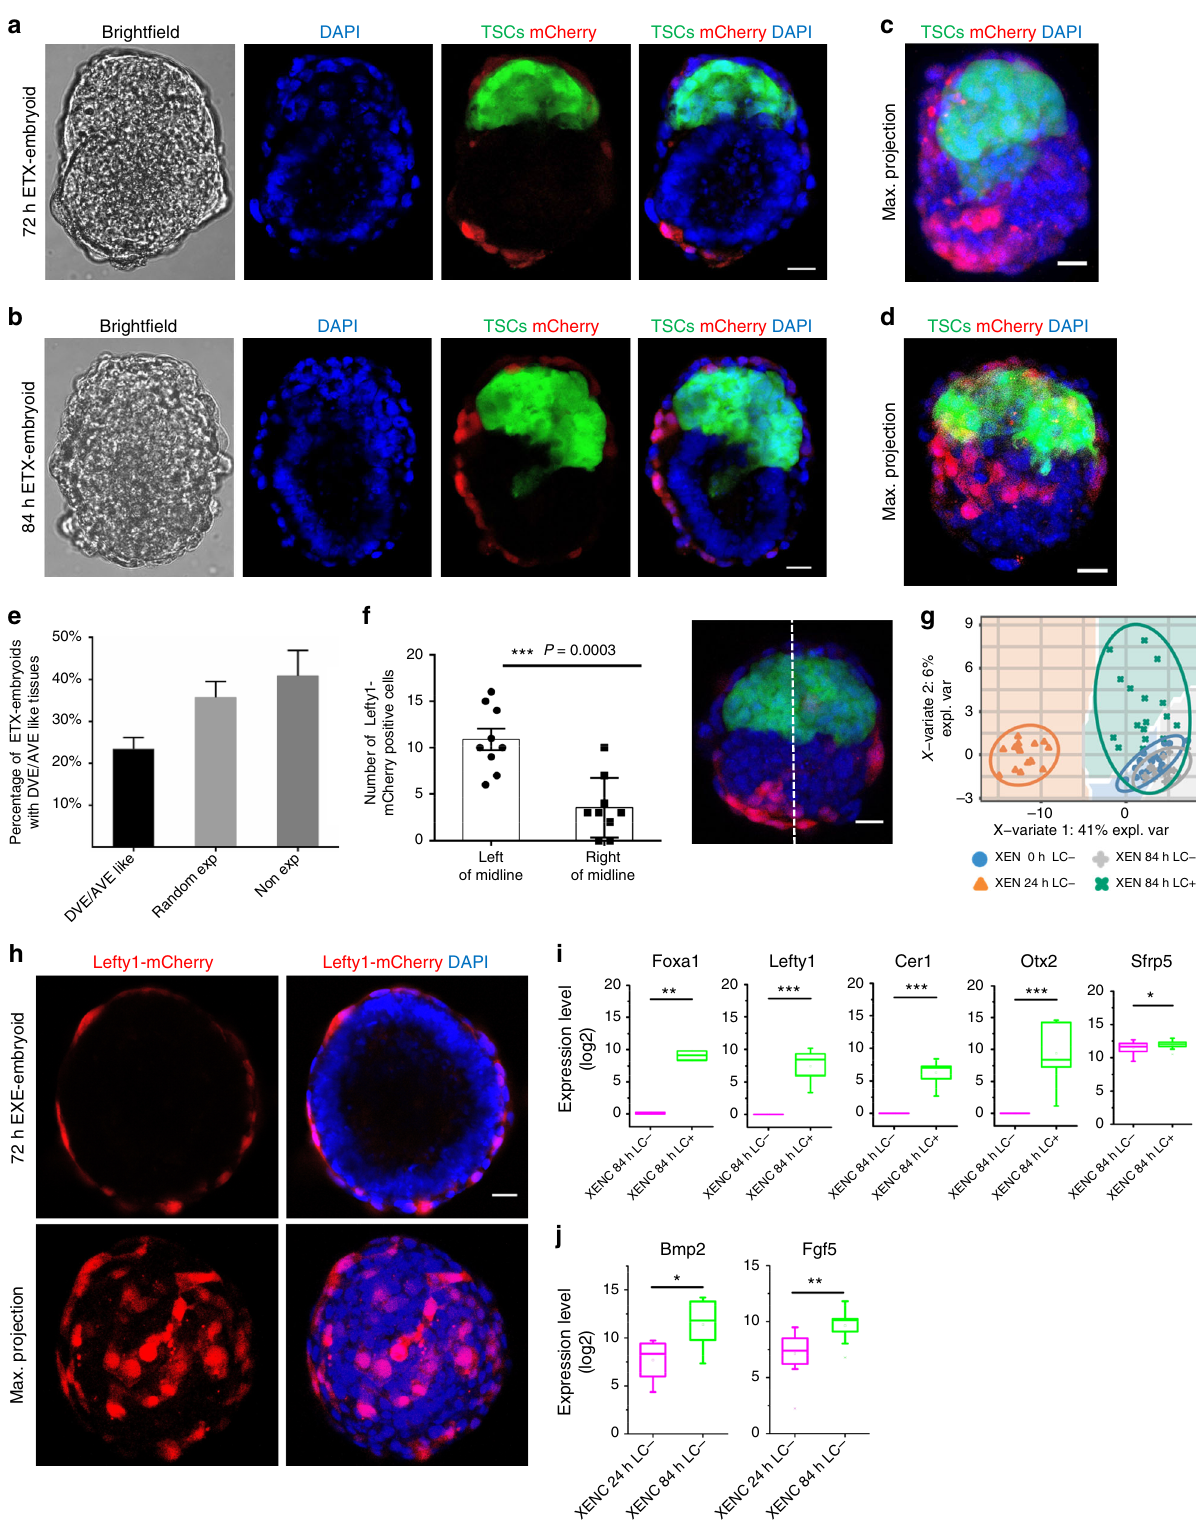
Fig. 4b, c). Localization of the cell adhesion protein E-Cadherin revealed that the nuclei in the ESC compartment were aligned with the cavity. These morphogenetic steps are similar to those seen during the development of EPI-explants 27,28 (Fig. 2b,